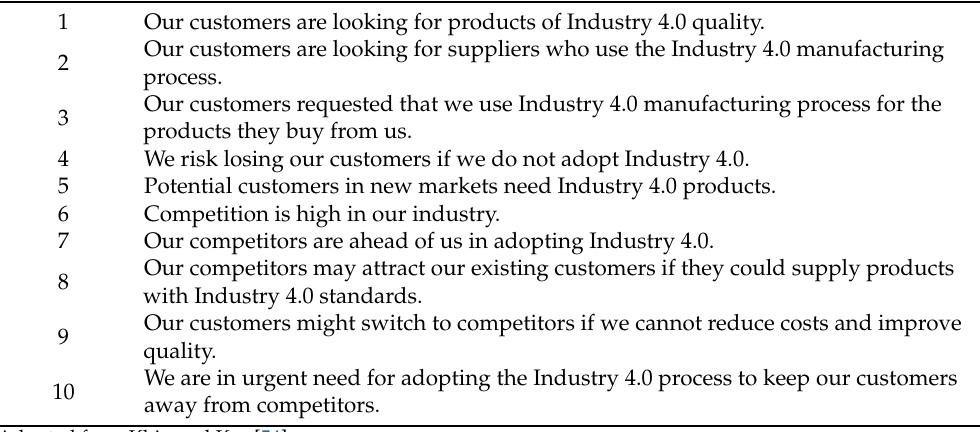
Table 6. Measurement items for customer needs and competitive